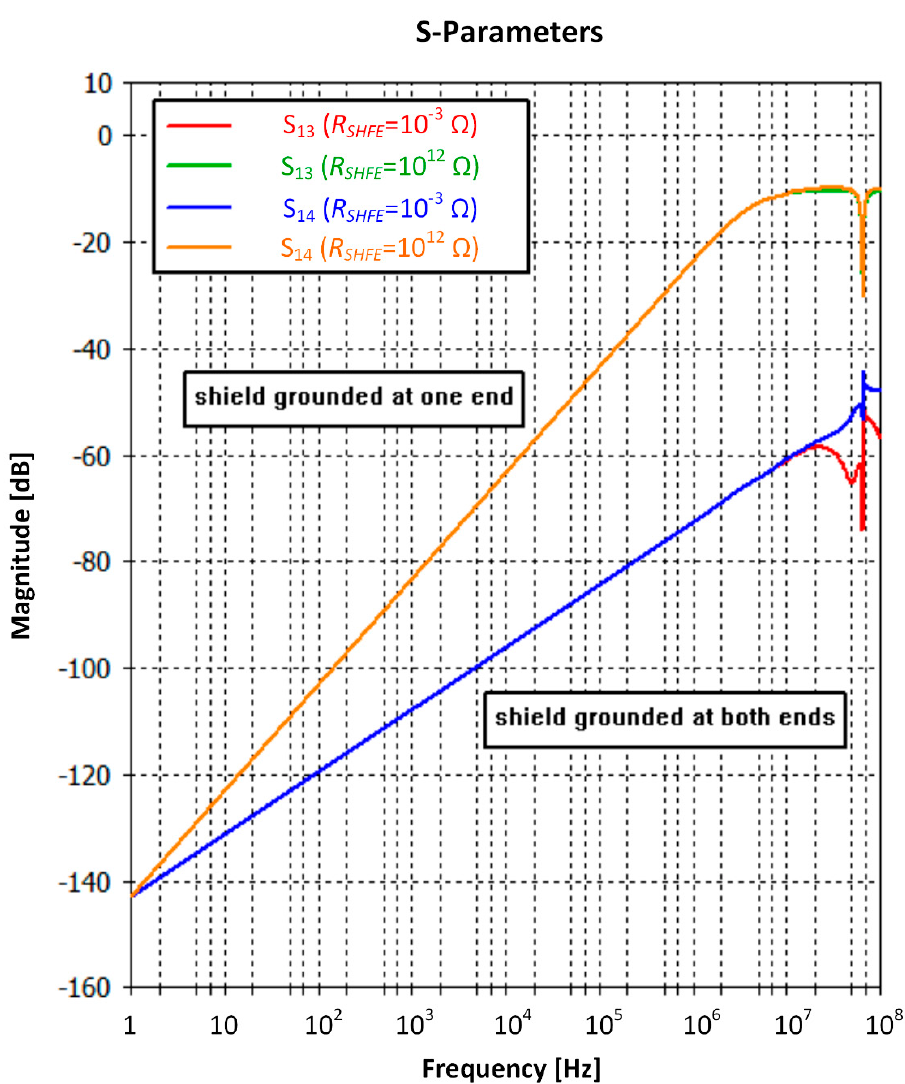
Figure 15. The comparison of S-parameters for shield grounding cases A (one side termination to GND) and B (both side termination to GND).